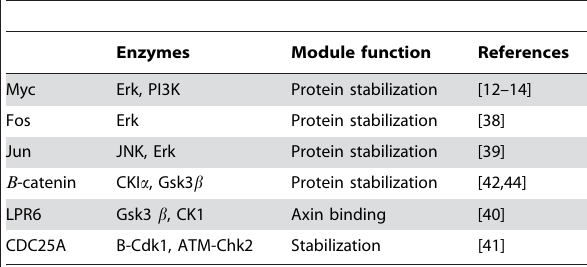
Table 1. Examples of protein modulation by sequential